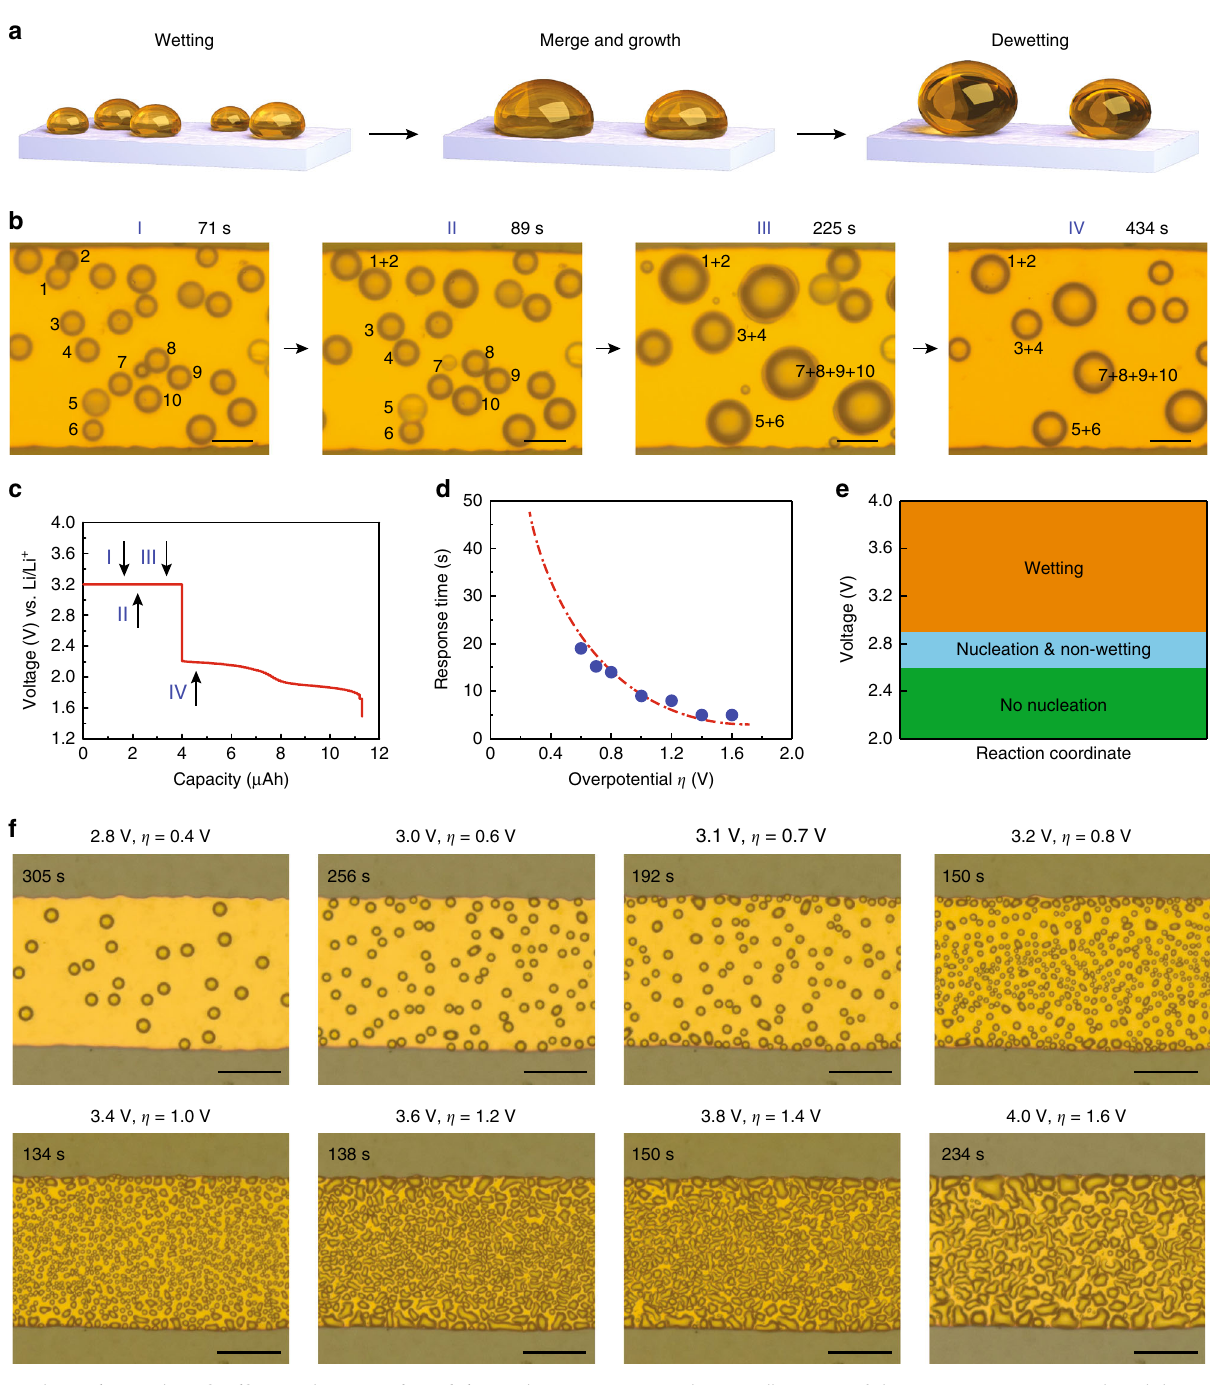
Fig. 2 Direct observation of sulfur wetting, growth, and de-wetting processes. a Schematic illustration of the wetting, merging, growth and de-wetting processes of the sulfur droplets on gold electrode. b In situ real-time imaging and c corresponding voltage versus capacity curves for the wetting, merging, growth and de-wetting processes. The numbers shown in ( b ) refer to the droplets which will merge and grow. Scale bar in ( b ) is 20 μ m. d Plot of the sulfur droplet response time versus overpotential ( η ). The response time refers to the shape change of the droplets from the wetting state to a near-spherical shape. The dashed line is a guide for the eyes. e Voltage-dependent no-nucleation range (below 2.6V), nucleation but non-wetting range (2.6 – 2.9V) and wetting range (higher than 2.9V). f Snapshots of sulfur droplet wetting on gold at different voltages for a fi xed total capacity of 0.001 mAh. Scale bar in ( f ) is 50 μ